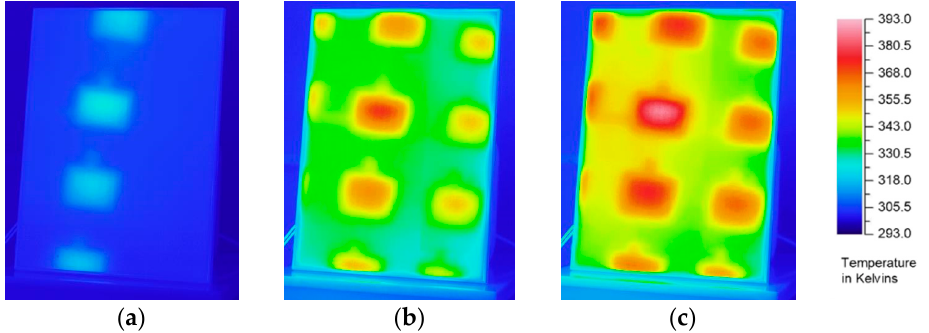
Figure 6. Temperature distribution on the front side of the 50 Wp PV panel during experiment: ( a ) beginning of the experiment, ( b ) after 7.5 min, ( c ) after 15 min (visible areas with higher temperatures are a result of the configuration of the light source).